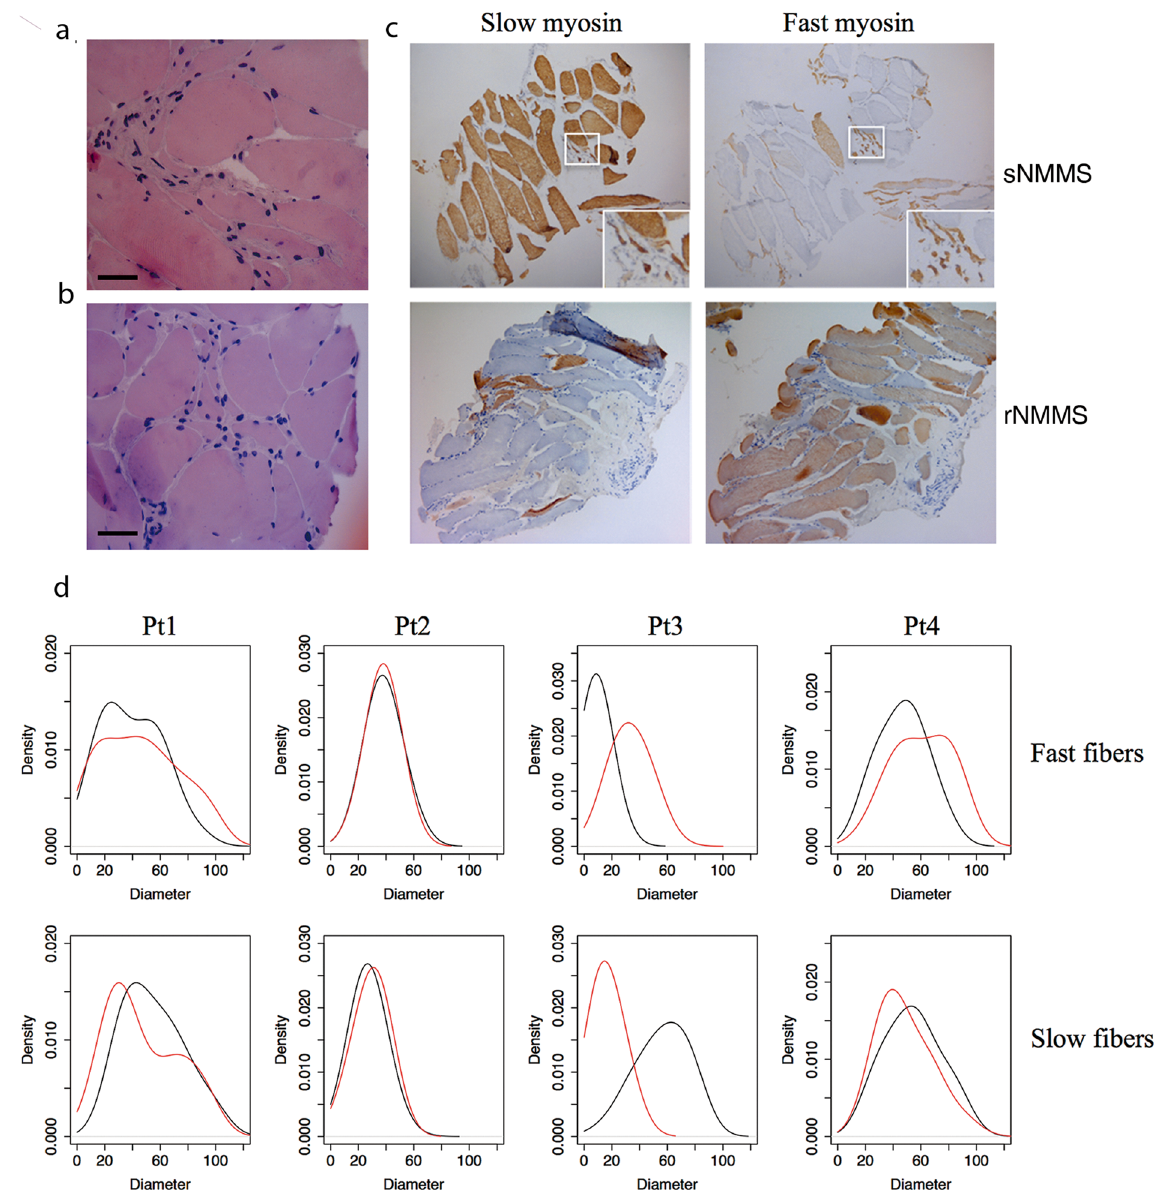
Figure 4. Morphologic and morphometric analysis of untreated and NMMS treated muscles. ( a ) Hematoxylin and eosin staining of muscle biopsies in sNMMS- and ( b ) rNMMS-treated muscles display grouped atrophy and scattered hypertrophic fibers (scale bar 50 µ m). ( c ) Immunohistochemical staining for slow and fast myosin show that the majority of the fast fibers are atrophic in the representative sNMMS muscle (upper panel). The contralateral rNMMS-treated muscle (lower panel) is characterized by a prevalence of fast fibers. ( d ) Density estimation of the diameter for fast and slow twitch fibers across 4 patients, showing a significant shift in the peak fast fiber diameter towards higher values in rNMMS (red line) if compared with sNMMS (black line) (p <